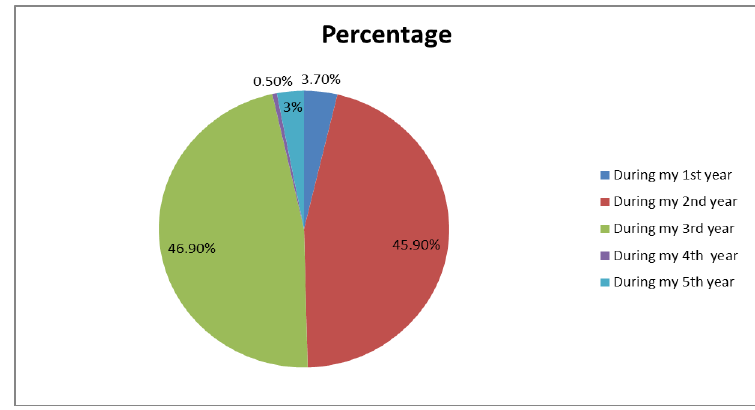
Figure 1: The year of taking entrepreneurship